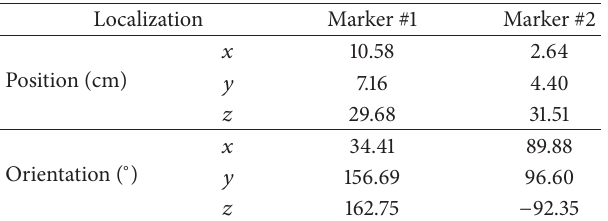
Figure 5: Example of arthroplasty surgery environment with aug- mented reality. Table 1: Localization of the markers.